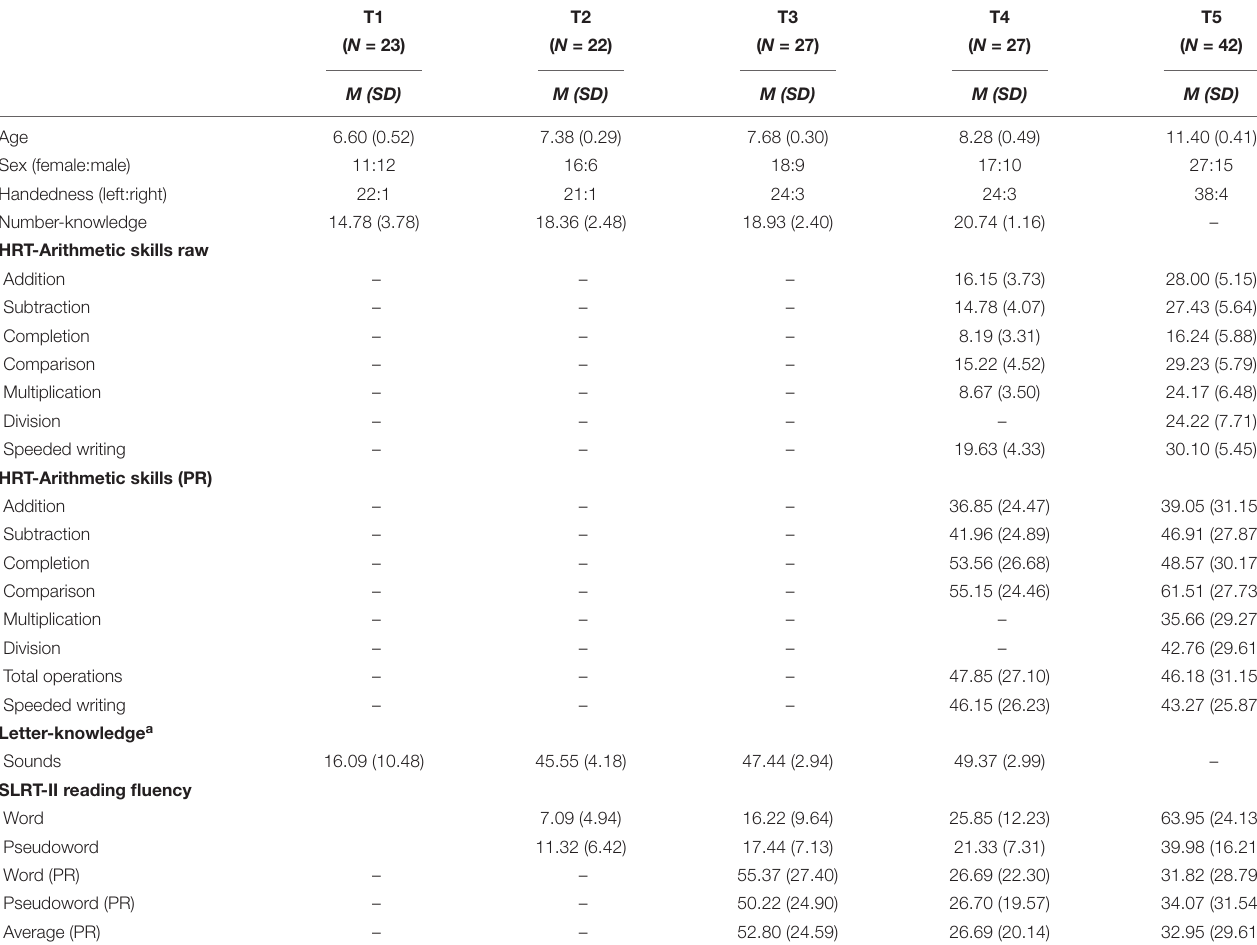
TABLE 2 | Descriptive statistics showing sample characteristics and cognitive assessment scores at each time